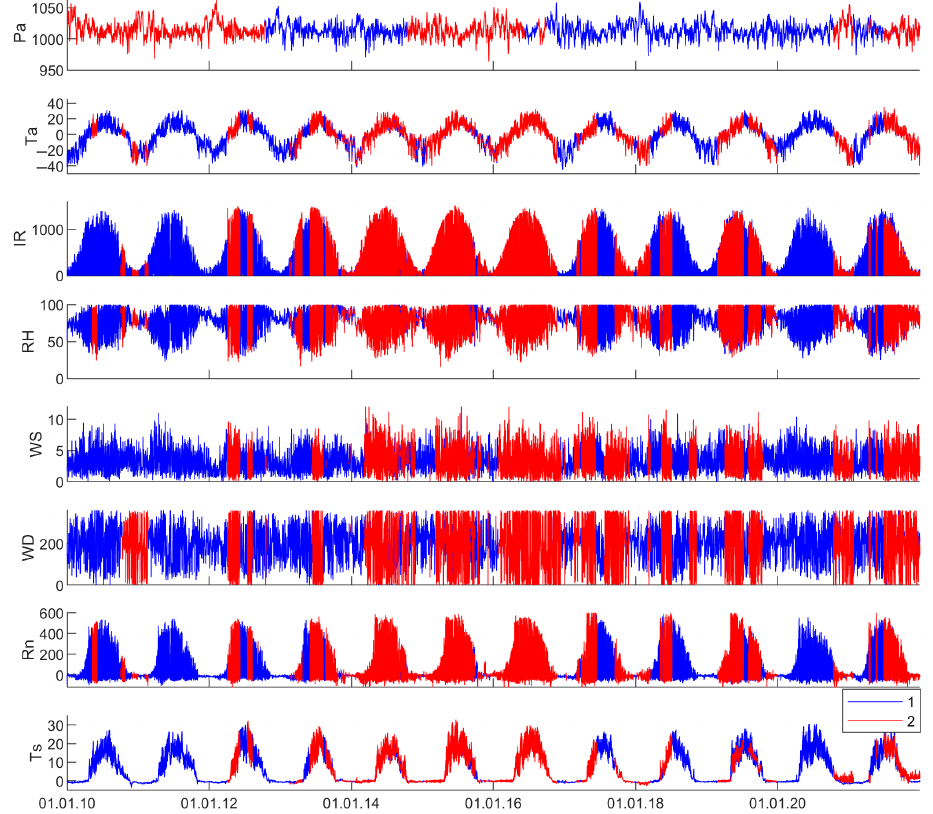
Figure 1. Meteorological variable data obtained from automated weather station (red) and recon- structed from the GPRexp model (blue). Pa—air surface pressure (hPa), Ta—air temperature (°C), IR—incoming photosynthetically active radiation (µmol/m 2 /s), RH—relative air humidity (%), WS—wind speed (m/s), WD—wind direction (deg), Rn—net radiation (W/m 2 ), Ts—soil temperature at 5 cm (°C).